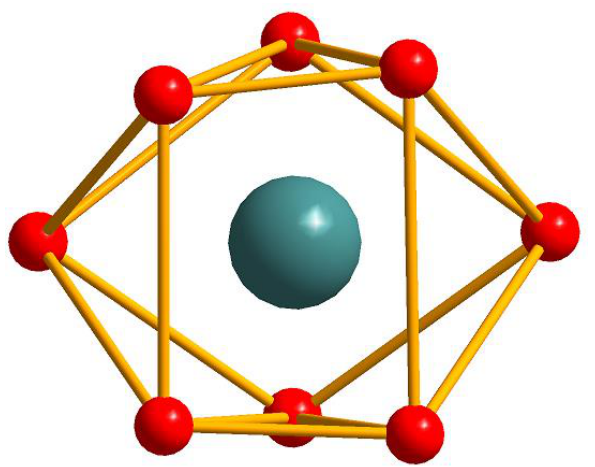
Figure 7. The distorted square antiprism coordination geometry of Ho(III) ion in 14 with the HoO 8 sphere.